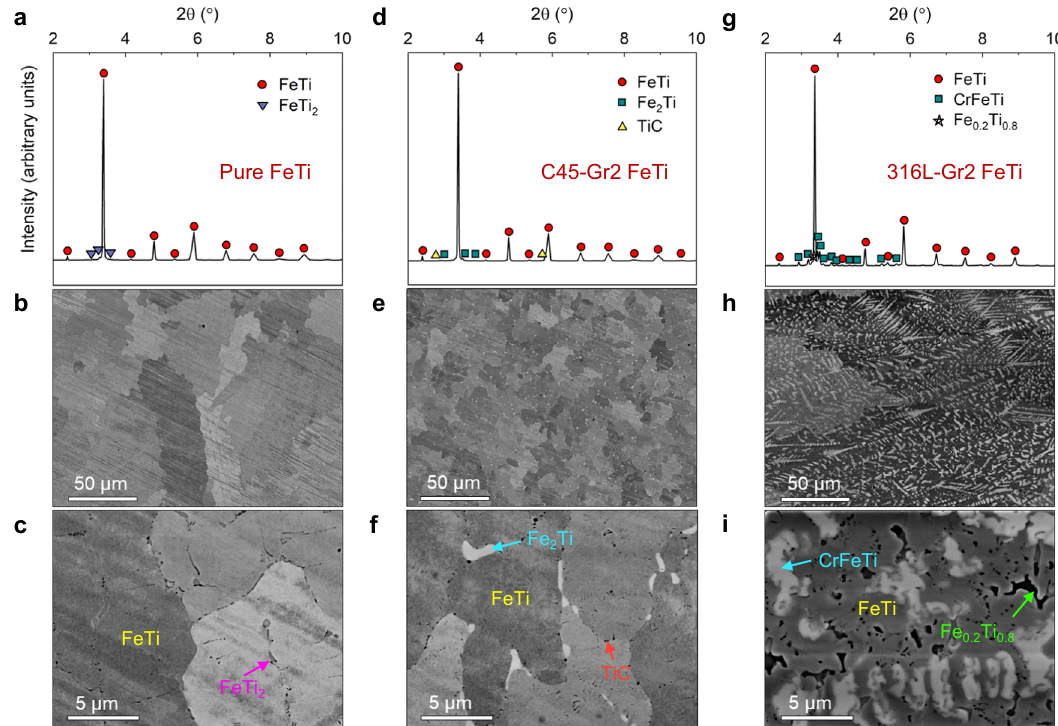
Fig. 1 Microstructures of as-cast pure FeTi, C45-Gr2 FeTi, and 316L-Gr2 FeTi alloys. a – c HEXRD ( λ = 0.124 Å) patterns and corresponding SEM images of pure FeTi. d – f HEXRD ( λ = 0.124 Å) patterns and corresponding SEM images of C45-Gr2 FeTi. g – i HEXRD ( λ = 0.124 Å) patterns and corresponding SEM images of 316L-Gr2 FeTi,